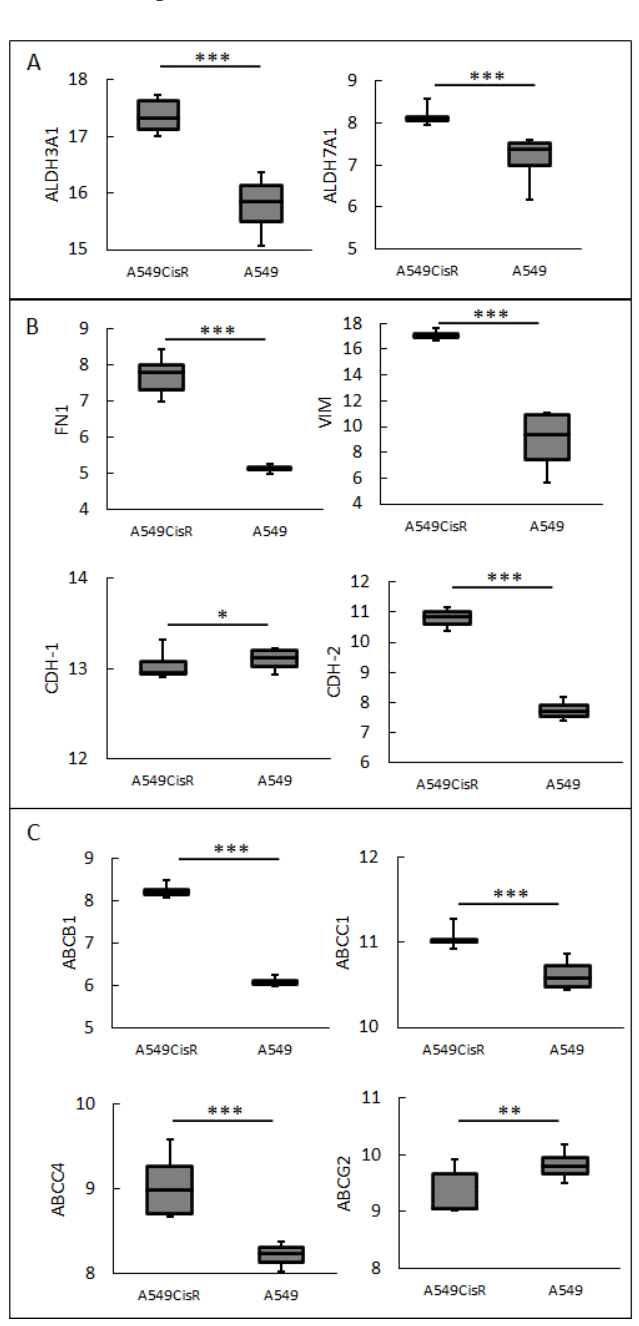
Figure 2. Cisplatin-resistance-related changes in mRNA expression of ALDH family proteins ( A ), EMT markers ( B ), and ABC proteins ( C ). NSCLC cell line A549 and its cisplatin-resistant variant A549CisR mRNA levels were analyzed using microarray dataset GSE108214, acquired from the public Gene Expression Omnibus (GEO) databases [59]. Normality test (Shapiro – Wilk) was per- formed, followed by the Mann – Whitney U test; * p < 0.05; ** p < 0.005; *** p < 0.001, not statistically significant — no indicator.